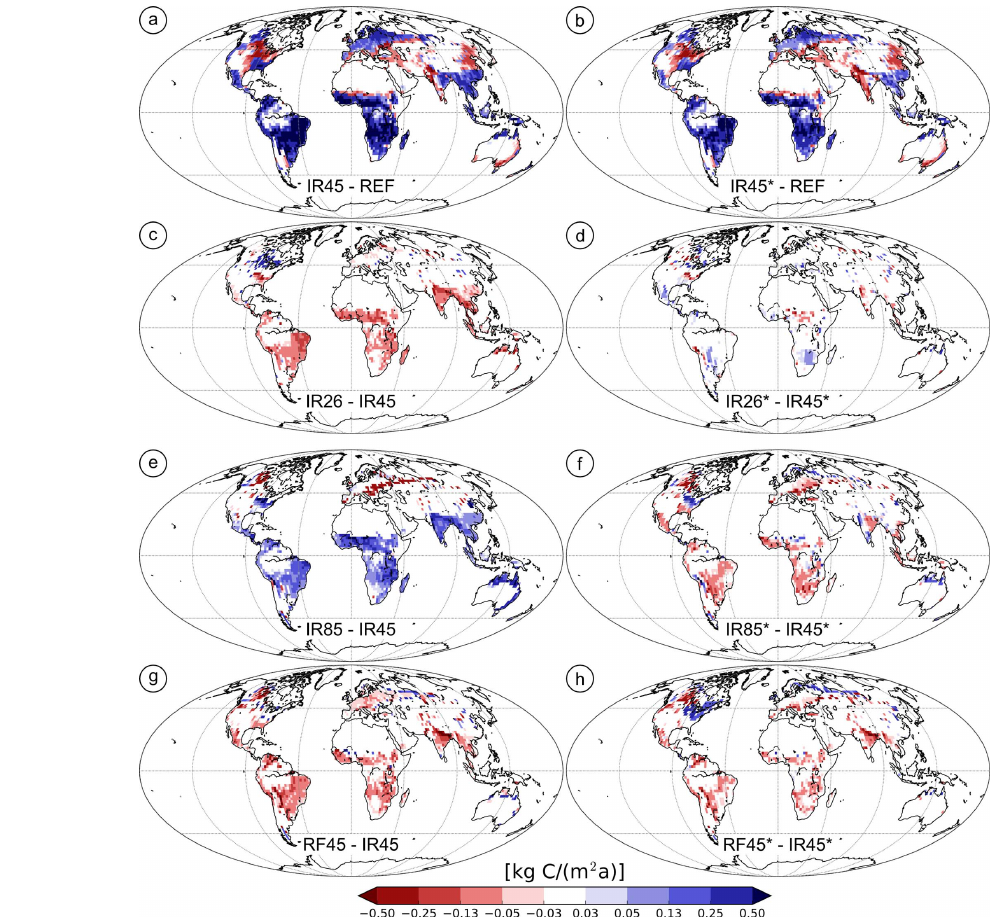
Figure 7. Productivity in the most productive 15% of the ice-free land surface. (a) The difference between the net primary productivity in 2100 (IR45) and the present day (REF) when the extent of future croplands is limited to the most productive 15% of the ice-free land = 2.5). (b) Same as (a) but without the CFE surface. For IR45 the global productivity of croplands increases by a factor of 2.5 (NPP IR45 Rel,2005 ∗ = 1.9). (c) The differences in productivity between the RCP2.6 and the RCP4.5 scenario (NPP IR26 = 2.2). (d) Same as (c) (NPP IR45 Rel,2005 Rel,2005 ∗ = 2.0). (e) Same as (c) but for IR85 and IR45 (NPP IR85 = 3.1). (f) Same as (e) but without the CFE but without the CFE (NPP IR26 Rel,2005 Rel,2005 ∗ = 1.8). (g) Same as (c) but for RF45 and IR45 (NPP RF45 = 2.2). (h) Same as (g) but without the CFE (NPP RF45 ∗ = (NPP IR85 Rel,2005 Rel,2005 Rel,2005